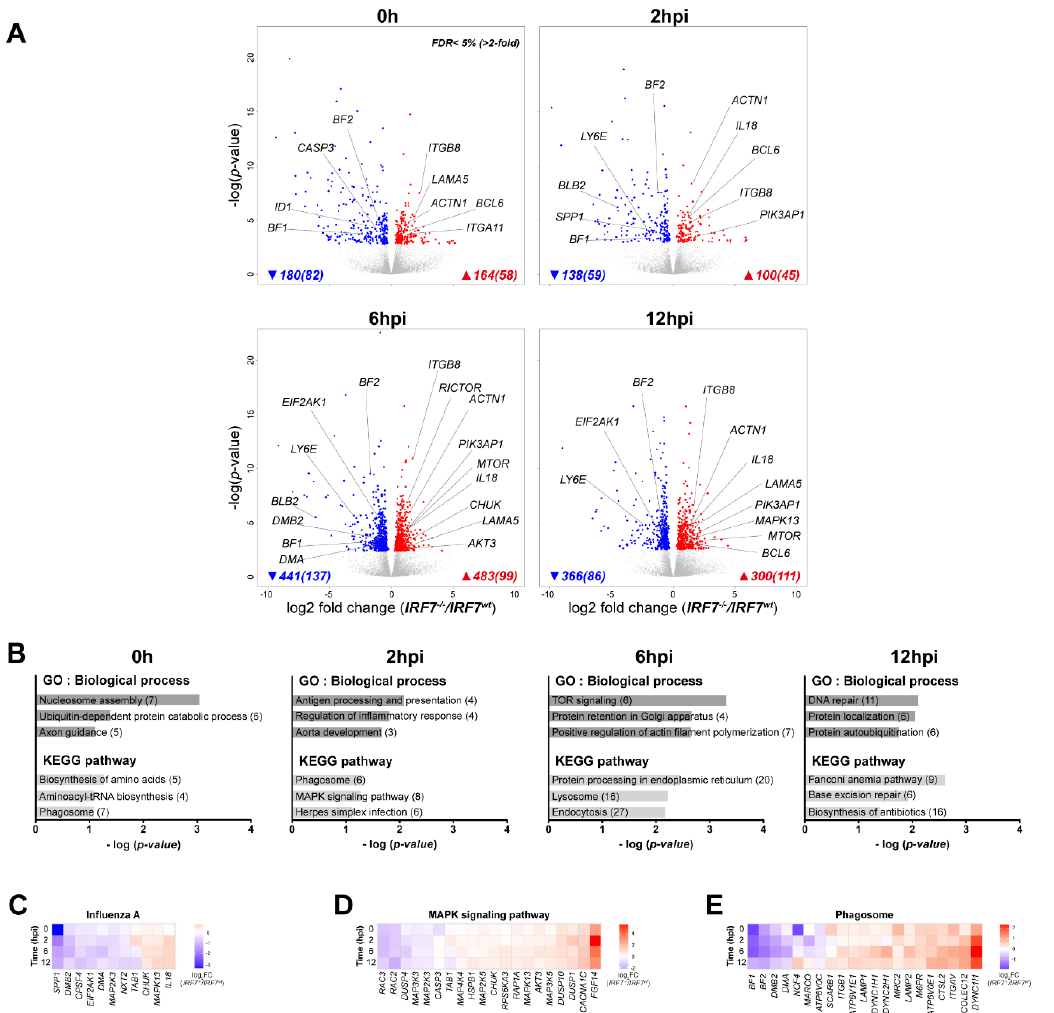
Figure 2. IRF7 deletion altered transcriptome regulation in DF-1 cells ( A ) Volcano plots of transcriptomic differences between IRF7 -/- and IRF7 wt cells at each time point; the colored dots correspond to significant differentially expressed genes (DEGs; False discovery rate (FDR) < 5 %). The numbers of DEGs are shown at the bottom of each plot, and the numbers of genes that have more than 2-fold changes are in the parentheses. ( B ) Gene ontology (GO) and pathway analysis by DAVID 6.8 using DEGs from each time point. The numbers of genes enriched in each biological process are in parentheses. ( C – E ) Heatmaps showing the expression fold change of DEGs in influenza A, MAPK (mitogen-activated protein kinase) signaling and the phagosome pathways at all time points ( IRF7 -/- / IRF7 wt ). Lists of DEGs from all time points in each pathway were combined to generate each heatmap.